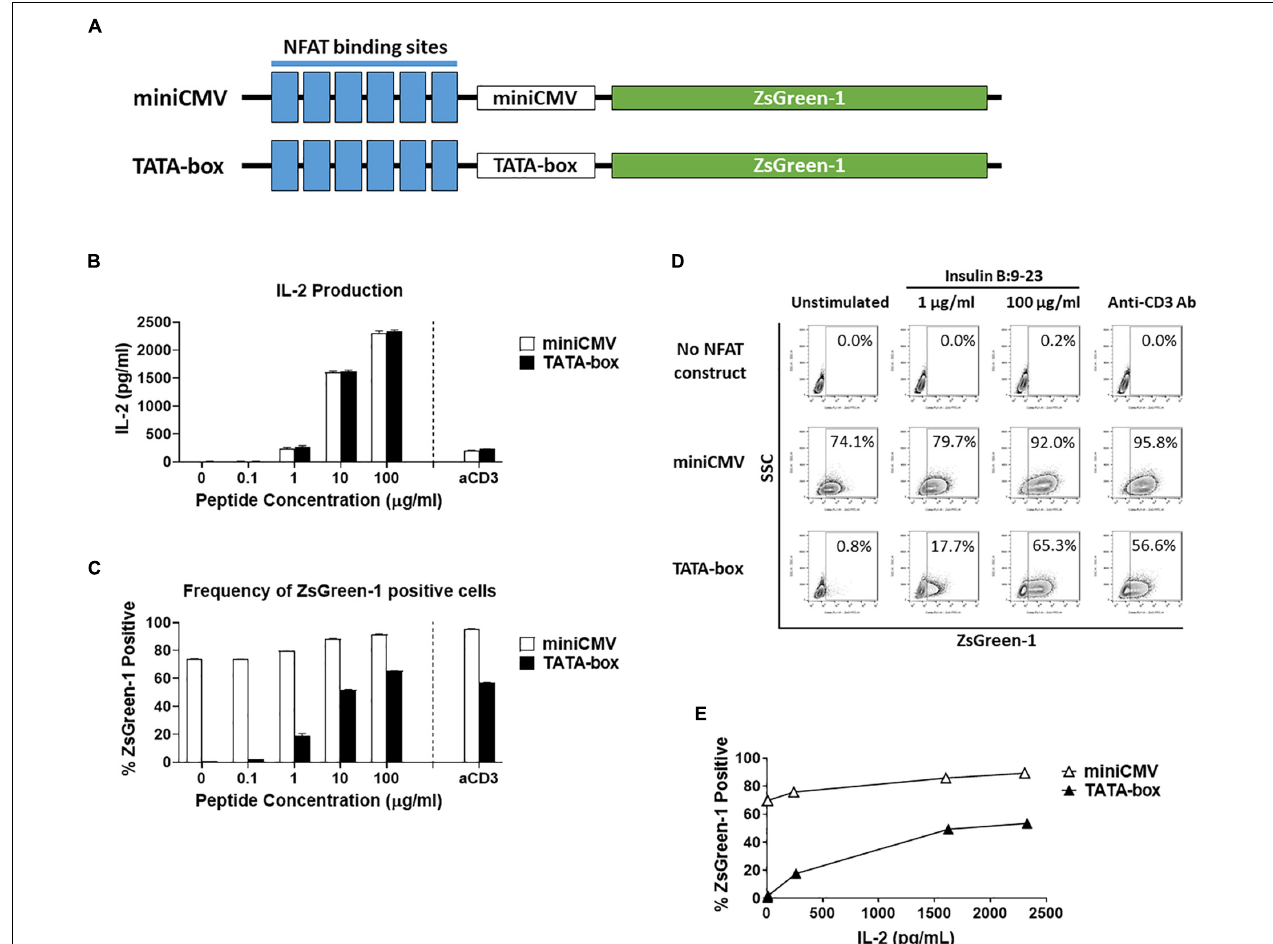
FIGURE 1 | Comparison of assistant promoters. (A) Schematic showing the relative positions of NFAT binding sites, assisting promoters, and ZsGreen-1 gene used in the NFAT-reporter constructs. (B–E) GSE.6H9 TCR 5KC T-hybridoma cells transduced with an NFAT-reporter construct containing the either miniCMV promoter or TATA-box were cultured with anti-CD3 antibody or different concentrations of the cognate peptide, insulin B:9-23, in the presence of K562 cells expressing HLA-DQ8. IL-2 production in culture supernatant was measured by ELISA (B) , and frequency of ZsGreen-1-positive 5KC T-hybridoma cells was measured by flow cytometry using the gating strategy shown in Supplementary Figure S1 (C) . Mean values ± standard error of the mean (SEM) from experiments performed in duplicate are shown. (D) Representative flow cytometry contour plots showing percentage of ZsGreen-1-positive cells containing either the miniCMV promoter or the TATA-box. Cells without an NFAT reporter construct are included to show the baseline fluorescent intensity that was used to establish gate placement for ZsGreen-1 positive cells. (E) Correlation between ZsGreen-1 positivity and IL-2 production for both cell lines. All results are representative of three independent